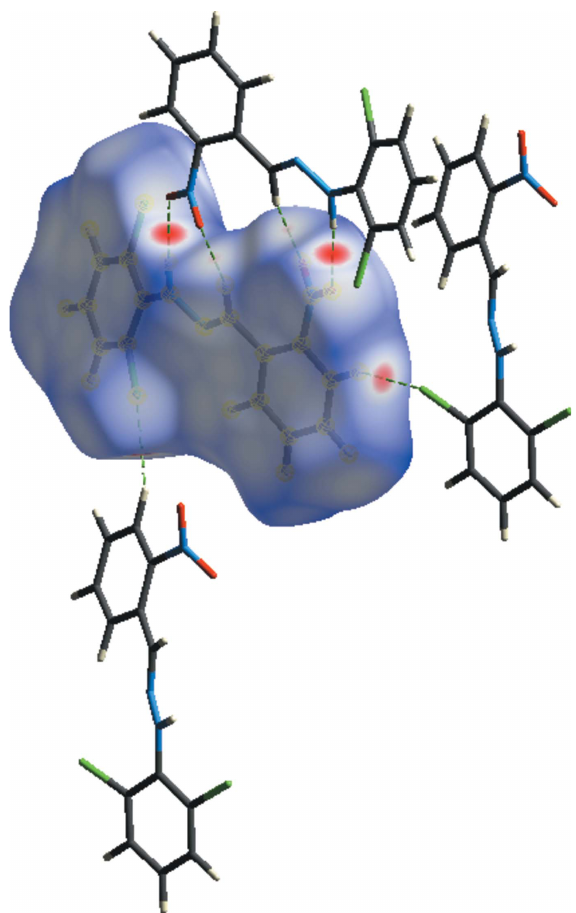
Figure 6 Aview of the Hirshfeld surface mapped for the title compound over d norm in the range (cid:4) 0.1980 to 1.3500 arbitrary units.